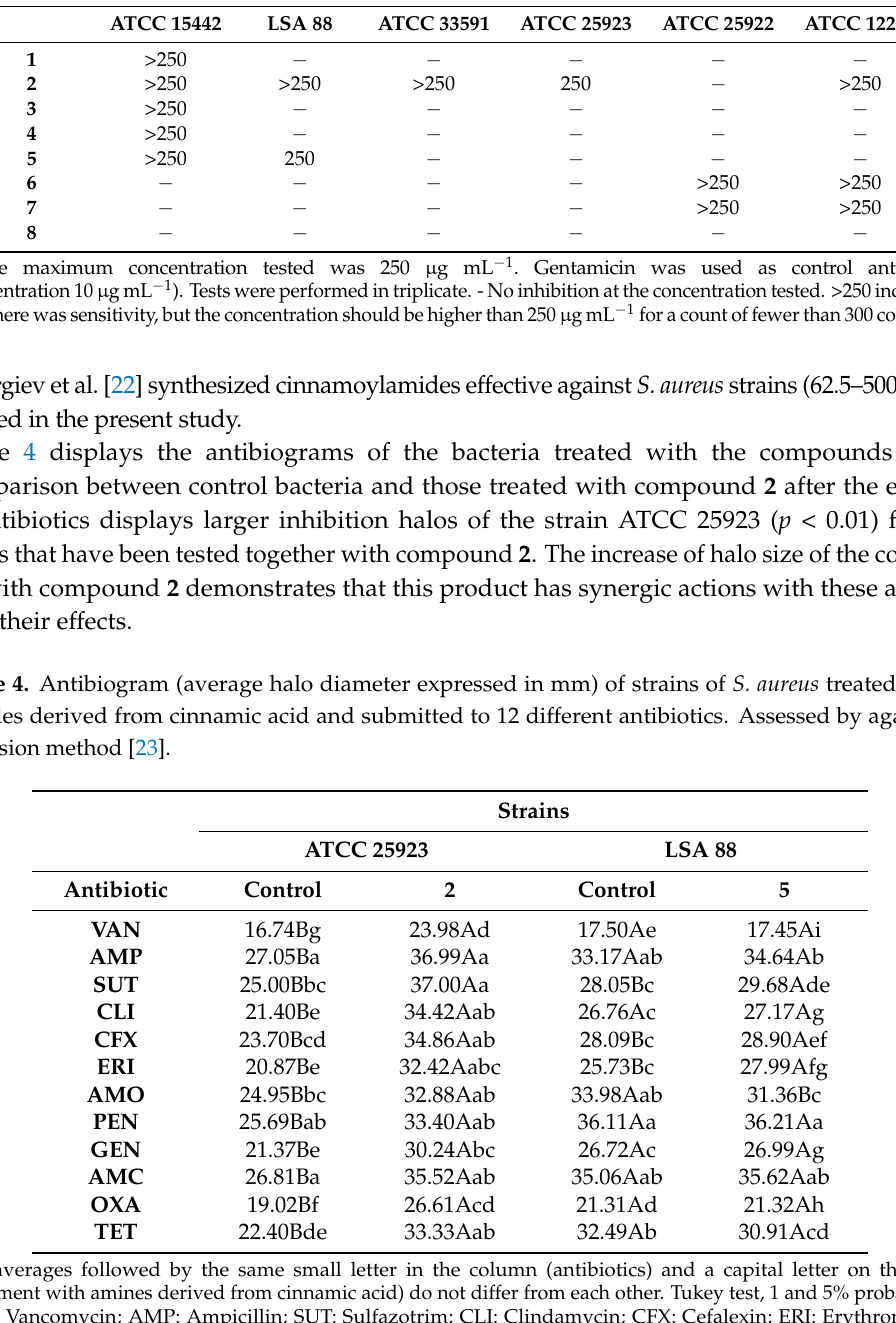
Table 3. Minimum inhibitory concentration (MIC) of compounds 1 – 8 against different bacterial strains. Compound